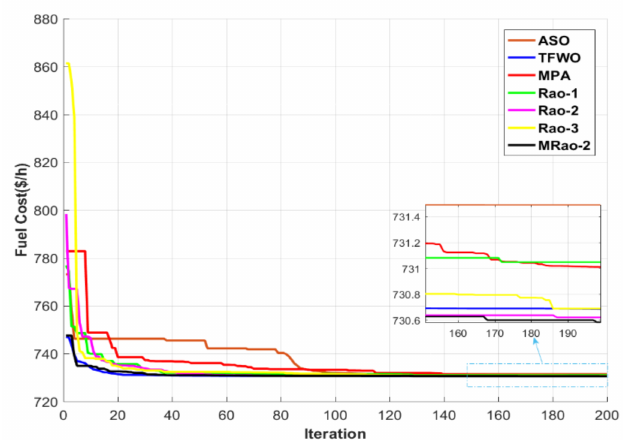
Figure 11. Convergence characteristics of all methods for case 3.